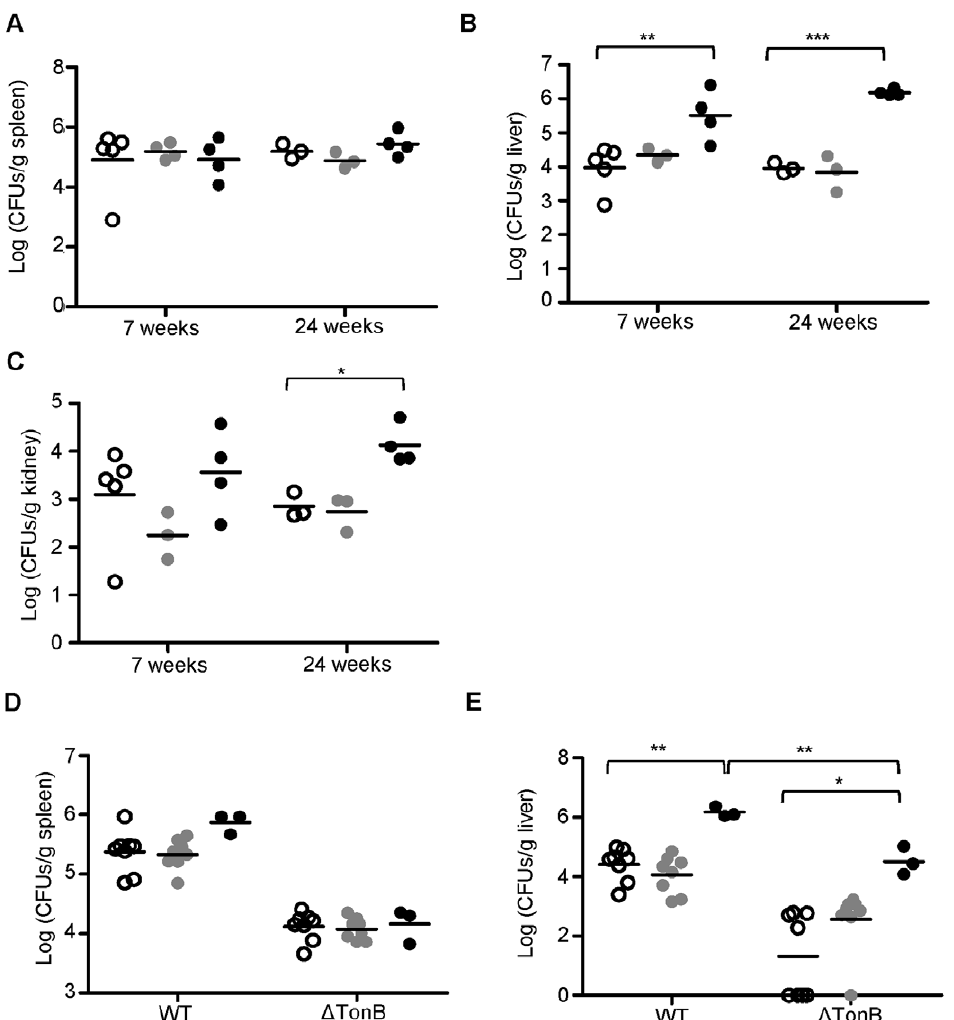
Figure 4. Bacterial load in spleen, liver and kidney after infection with Salmonella Typhimurium in Ity16 mutant, heterozygous and wild type mice. The bacterial load was measured 2 days after infection in the spleen (A), liver (B), and kidney (C) of wild type aged 7 weeks (open circle), and 24 weeks (open circle), heterozygous mice at 7 weeks (gray circle) and 24 weeks (gray circle) and Ity16 mutant mice at 7 weeks (filled circle) and 24 weeks (filled circle) (n=3–5 per genotype and age). Ity16 mutant mice present higher bacterial load in the liver and kidneys compared to heterozygous and wild type littermates. Bacterial load of Salmonella Typhimurium and D tonB Salmonella Typhimurium was measured 2 days after infection in spleen (D) and liver (E) of wild type (open circle), heterozygous (gray circle) and Ity16 (black circle) mice aged 7–12 weeks (n=3–8 per genotype). Results are representative of at least two experiments. An * represents a P-value of less 0.05; **represents a P-value of less than 0.001; ***represents a P-value of less than